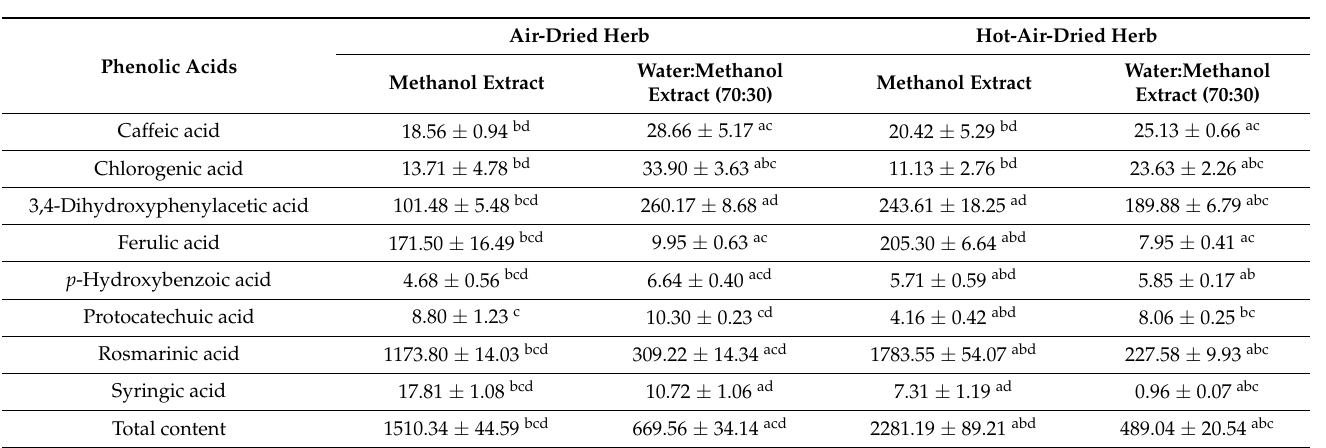
Table 2. Content (mg/100 g DW ± SD) of phenolic acids in methanol and water–methanol (70:30) extracts of B. officinalis